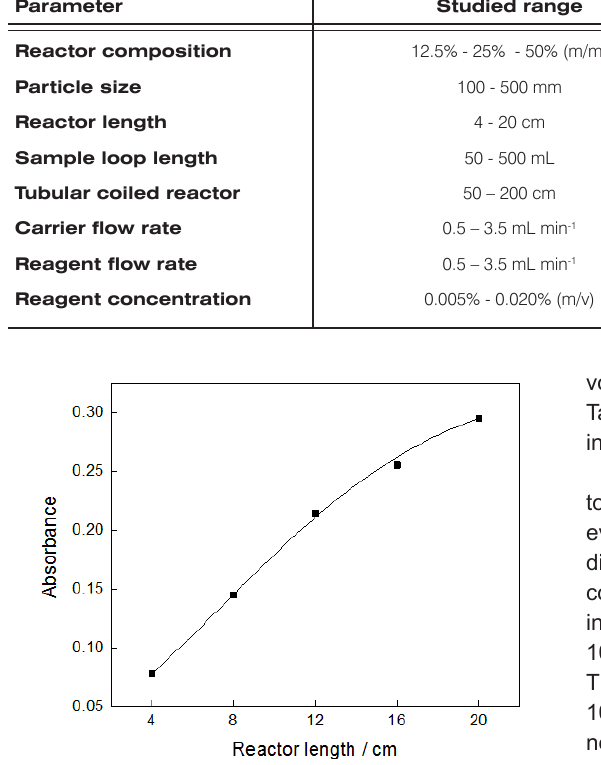
Figure 3. Effect of the reactor length on the absorbance intensity for 100 mL of 1.0×10 -3 mol L -1 dipyrone solution.